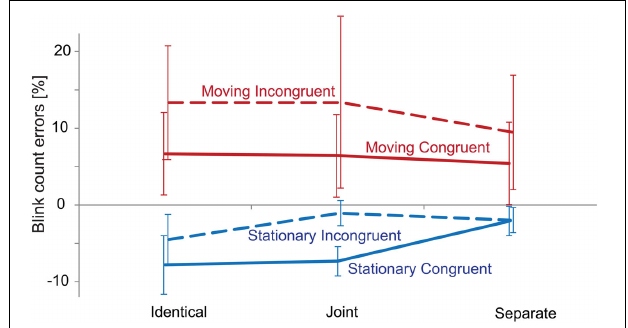
FIGURE 2 | Performance in the visual (blink counting) task. Group-averaged ( N = 21) percentage of blink count errors obtained in the Identical, Joint and Separate Co-locations, separately for the Stationary (blue) and Moving (red) × Congruent (continuous line) and Incongruent (dashed line) conditions. Negative values correspond to underestimation and positive values to overestimation of the number of blinks. Error bars show the standard error of